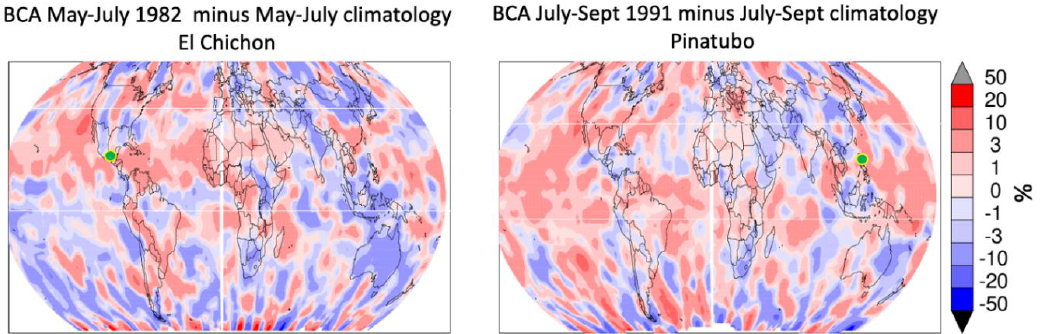
Figure 10. Perturbations of BCA induced by the El Chichón ( left ) and Mt. Pinatubo ( right ) volcanic eruptions. The global impact of the eruption emerges after the plume has been advected around the globe, which takes several weeks after the time of eruption. For El Chichón, which ended its eruption in early April of 1982, we average the months of May, June, and July of the that year and compare it with the May–July climatology over the entire record (1980–present). The same approach is used to determine the Mt. Pinatubo perturbation. For each volcano, the location of the eruption (green dots) and zonal extent of the SO 2 cloud (white lines) according to aircraft lidar measurements and stratospheric aerosol and gas experiment II (SAGE II) are shown.